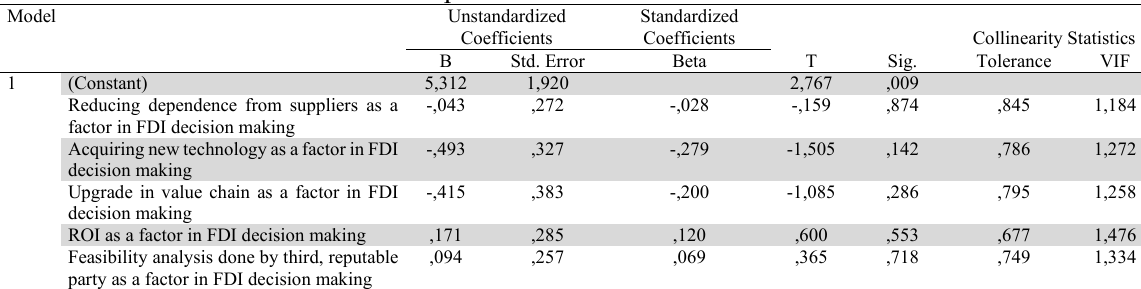
Coefficients in the model with rational predictors